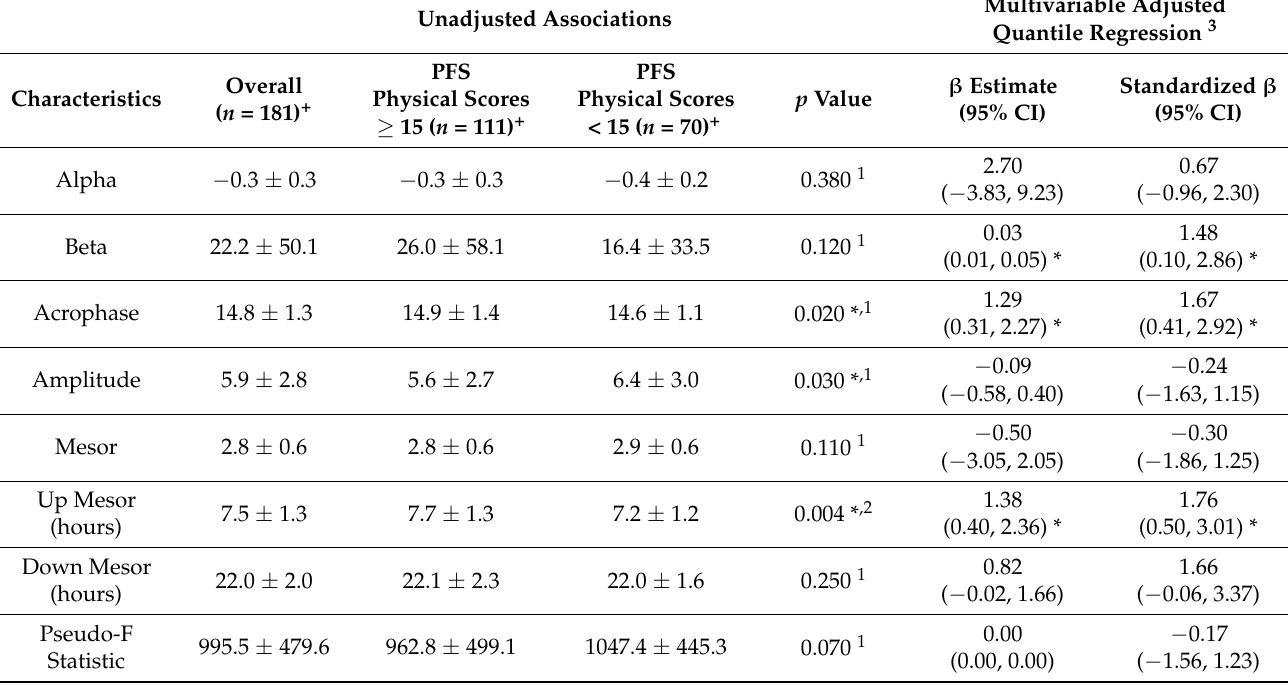
Table 2. Individual associations of rest–activity rhythm (RAR) characteristics by the Pittsburgh Fatigability Scale (PFS) perceived physical fatigability